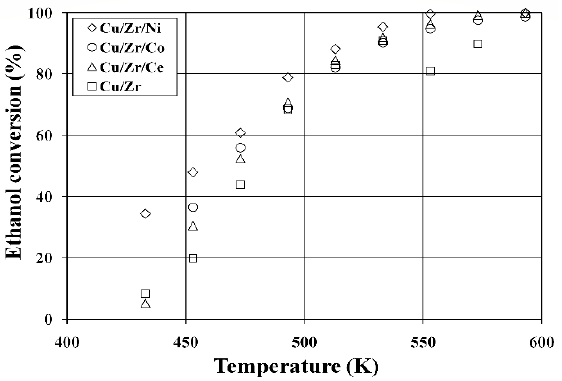
Figure 5. The effect of temperature on ethanol conversion in ethanol steam reforming (ESR) over tested catalysts.